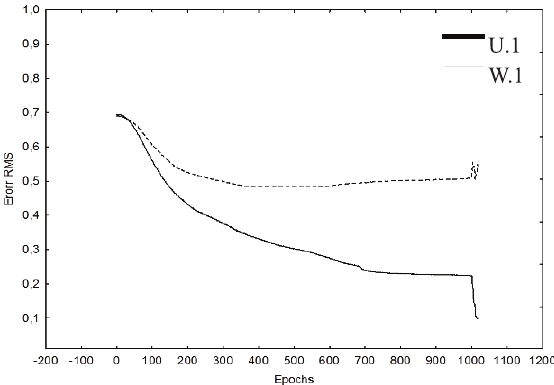
Figure 2. RMS error graph during the learning